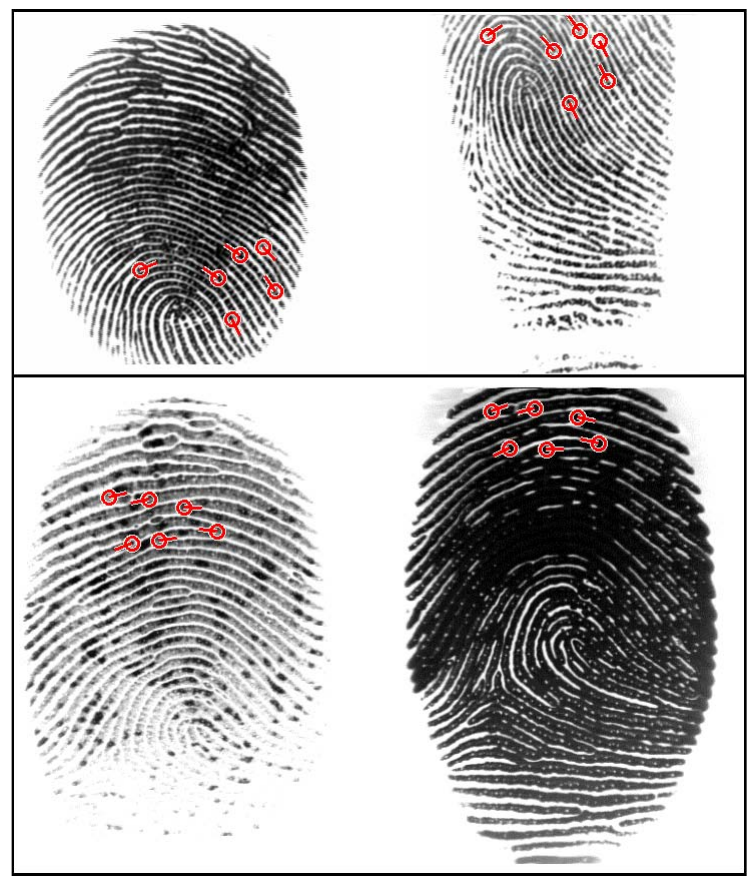
Figure 7. Two examples where all matching algorithms fail but our algorithm finds true matching minutiae. The first row contains fingerprints db1 36 1 and db1 36 4 of database DB1 A (FVC2002); the second row contains fingerprints 85 6 and 85 8 of database DB1 A (FVC2004).